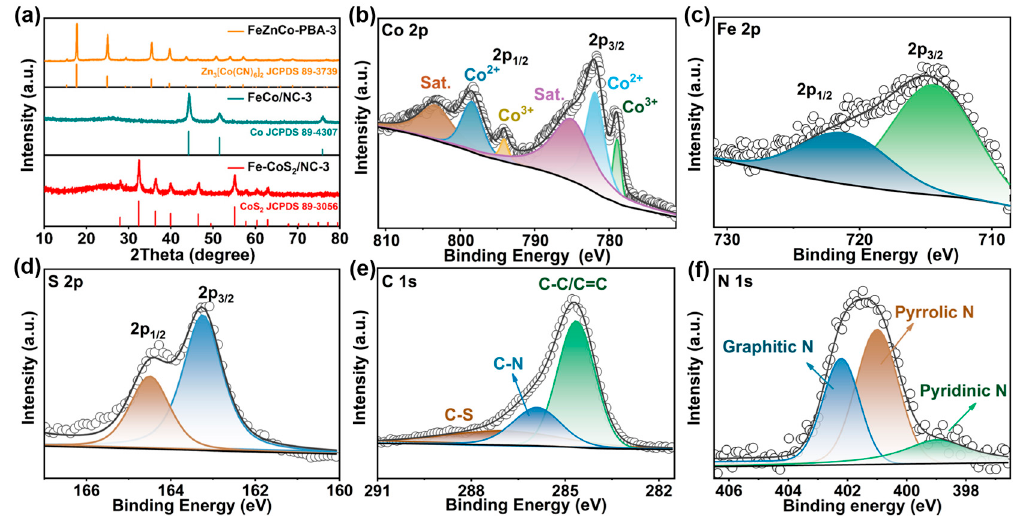
Figure 3. ( a ) XRD patterns of the FeZnCo-PBA-3, FeCo/NC-3 and Fe-CoS 2 /NC-3 spheres, ( b – f ) XPS spectra of the Fe-CoS 2 /NC-3 spheres: ( b ) Co 2p, ( c ) Fe 2p, ( d ) S 2p, ( e ) C 1s, and ( f ) N 1s, respectively.